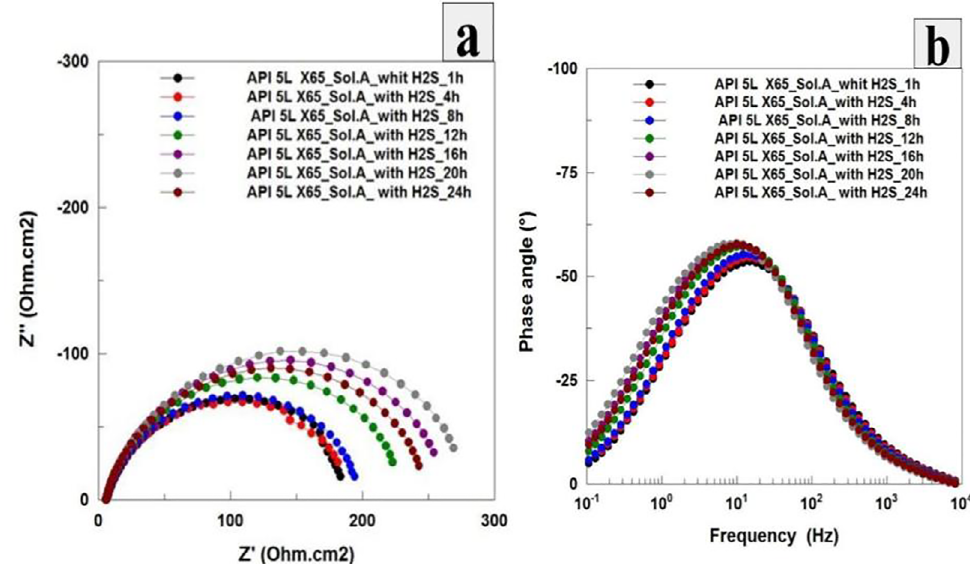
Figure 9. Nyquist (a) and phase angle (b) diagrams for the API 5L X65 steel during 24h immersion in deaerated solution S, sour medium. Procedure 2. A, NACE TM0284 (2011), saturated with H 2